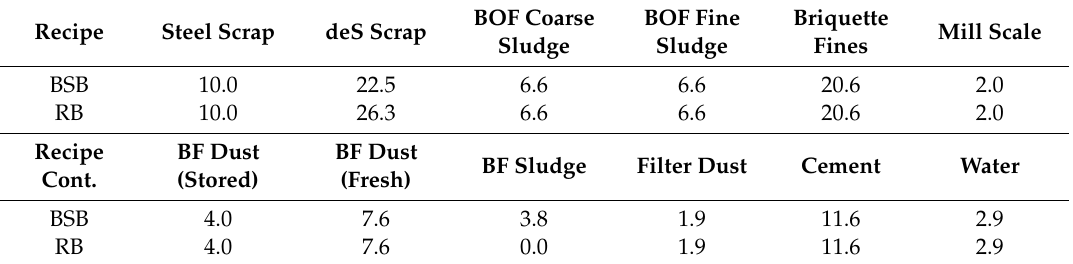
Table 3. Recipes of the BF sludge briquette (BSB) and reference briquette (RB) used in the full-scale BF trials (wt.%).